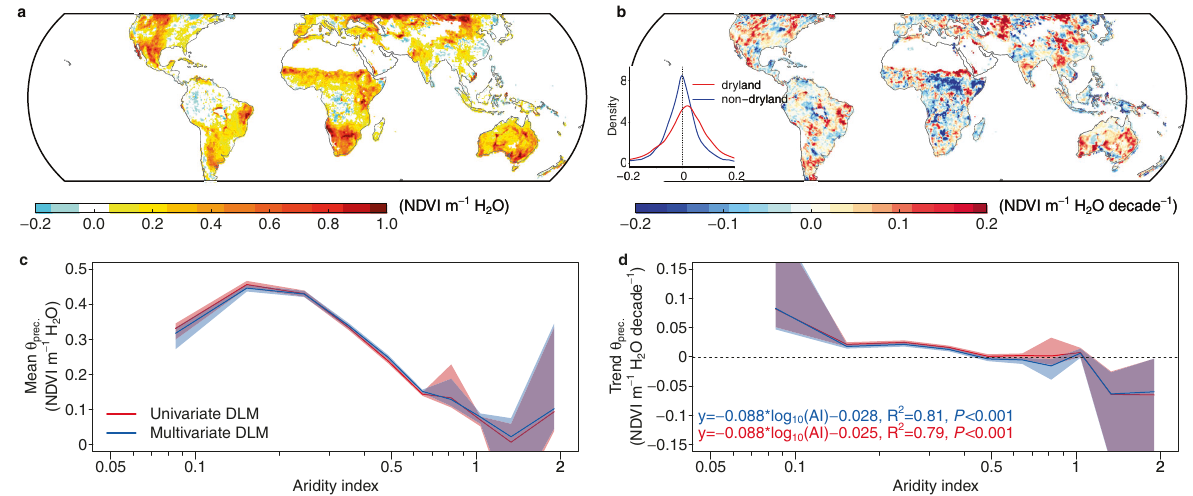
Fig.1|Spatialpatternsofprecipitationsensitivity( θ prec ). Mean( a )andtrend( b ) ofprecipitationsensitivityduring1981 – 2015obtainedfromamultivariatedynamic linear model (DLM). The inset in b shows the probability density of the precipita- tion sensitivity for dryland (red) and non-dryland (blue). The response of the ( c )